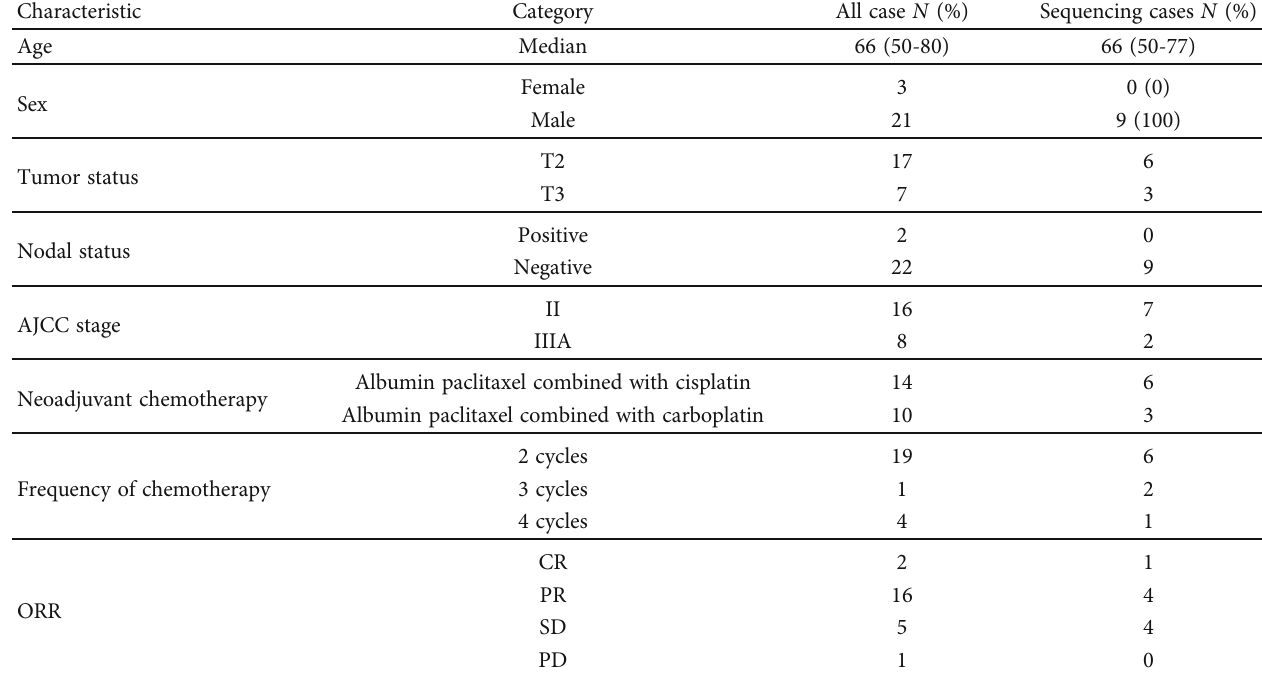
Table 1: Characteristics of